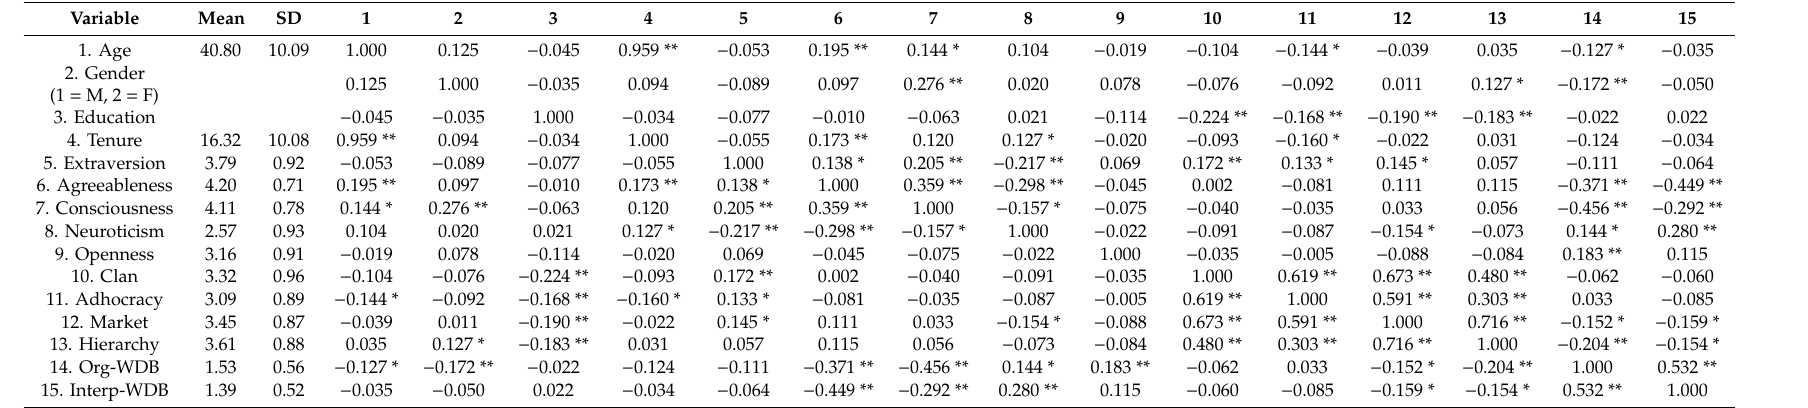
Table 1. Descriptive statistics and correlation between